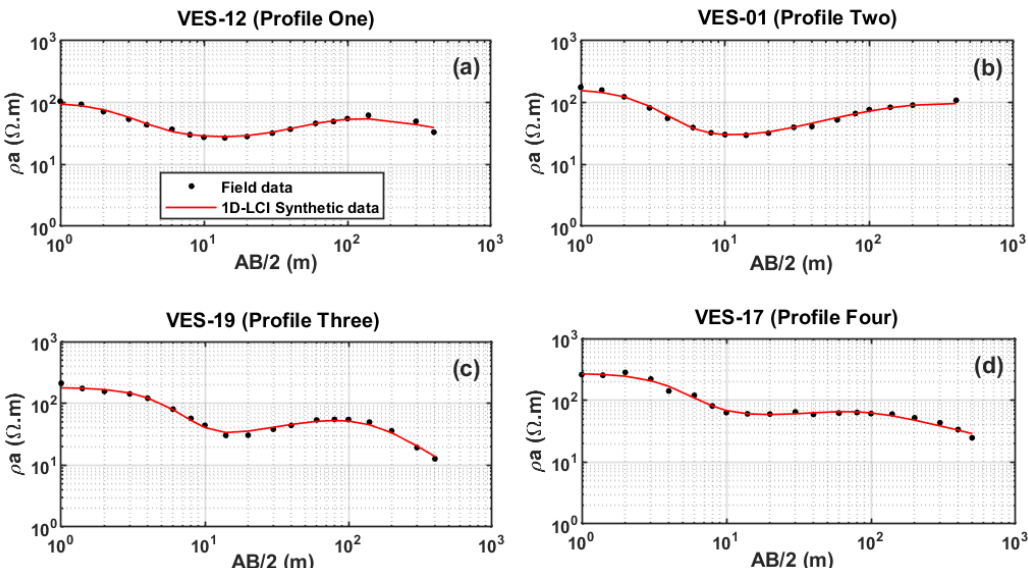
Figure 9. ( a , c ) Inversion result from synchronized 1D–LCI inversion model using five layers, constructed from DC soundings along profile three and four, respectively. ( b , d ) Detailed plot of the resolution analysis of model parameters calculated from final model of 1D–LCI inversion (resistivities; Res.1–Res.5 and thicknesses; Th.1–Th.4) along profiles three and four, respectively. The color-coding of the analysis ranging from red (well resolved parameter, STD factor = 1) to blue (moderately resolved parameter, STD Factor = 1.2).